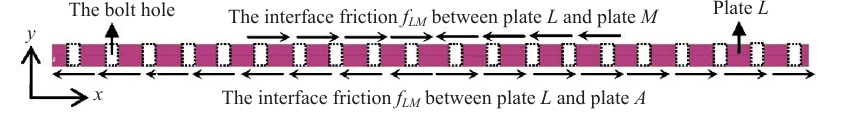
Plate L The bolt hole